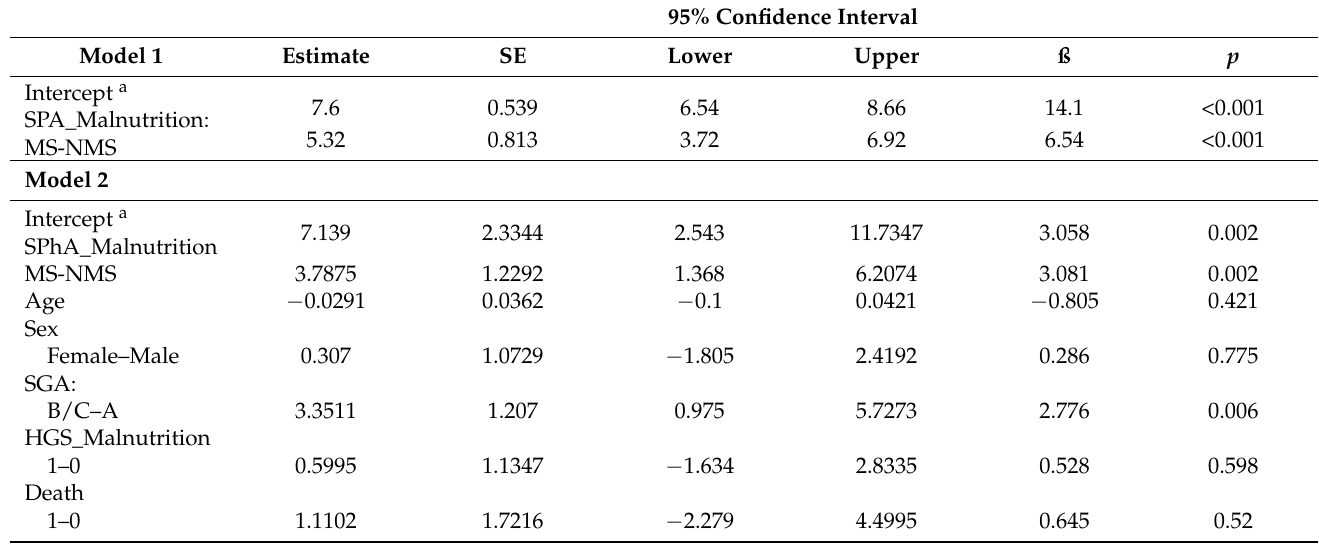
Table 5. Association between SPhA-malnutrition and